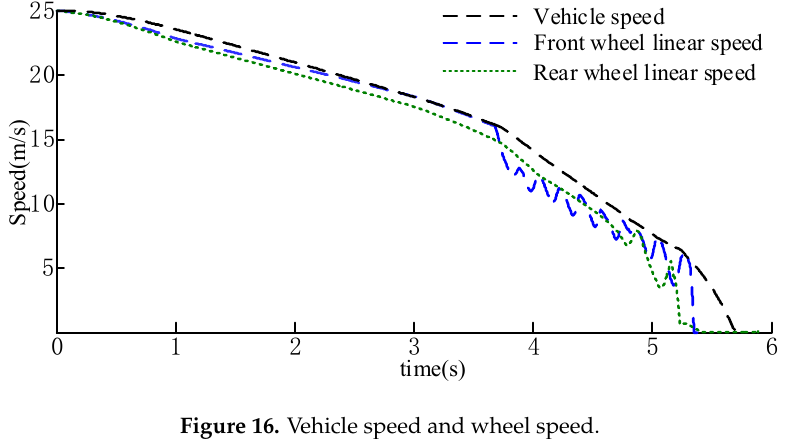
Figure 15. Brake intent variation.